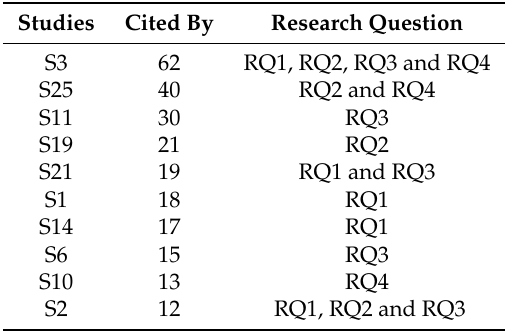
Table 2. Top ten cited papers according to Google Scholar. Studies Cited By Research